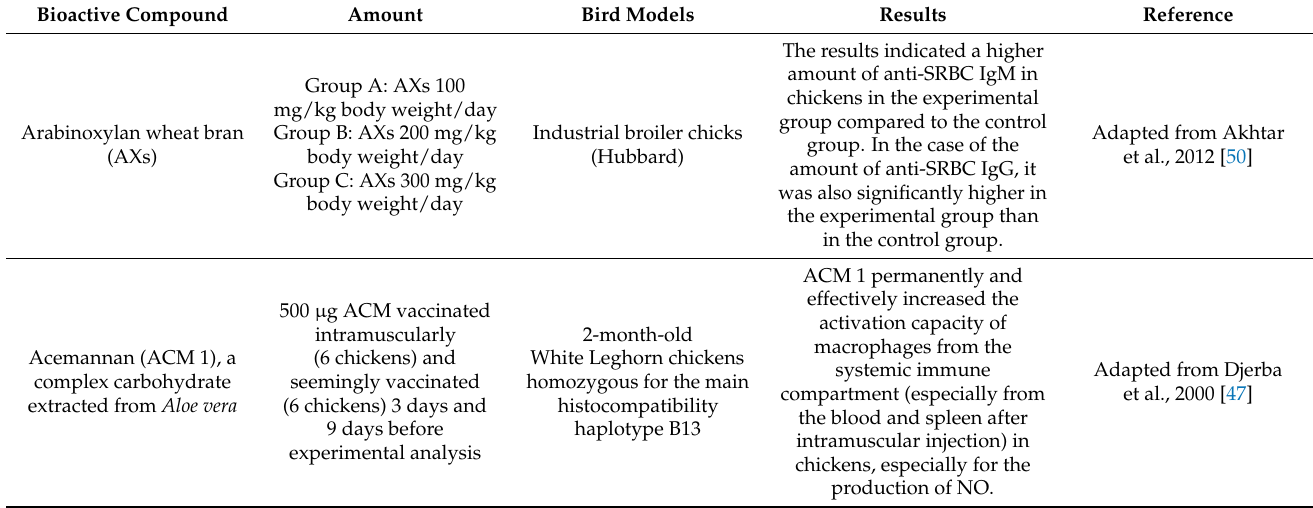
Table 1. Examples of bioactive products and compounds with immunomodulatory properties in